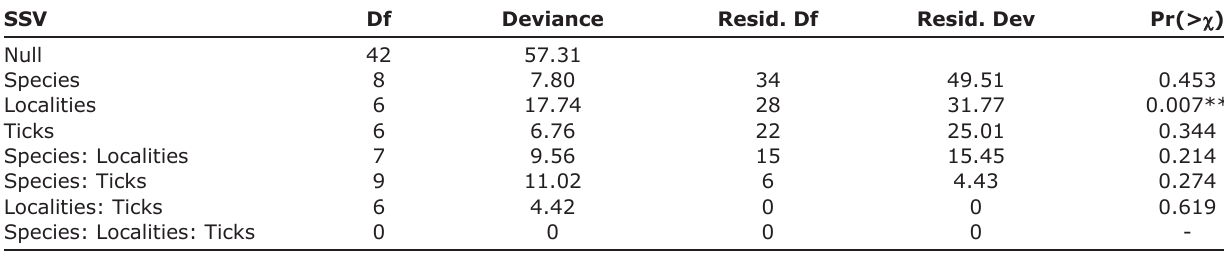
Table-5: Full model deviance analysis table.